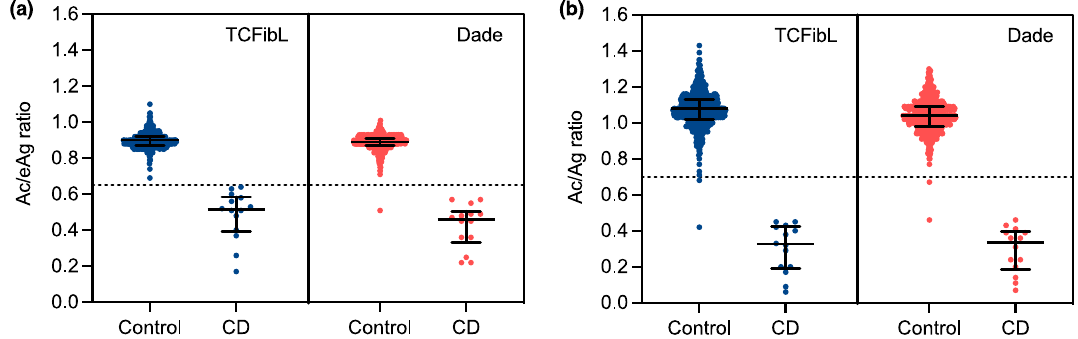
Figure 2. Comparison of Ac/eAg and Ac/Ag ratio in validation cohort. A scatter plot for Ac/eAg ratio ( a ) and Ac/Ag ratio ( b ) analyzed in the validation cohort. The left area shows results obtained with Thrombocheck FibL reagent (TCFibL, blue), and the right area shows results obtained with Dade Thrombin Reagent (Dade, rose). The dotted line shows the predicted cutoff of 0.65 ( a ) or the previously suggested cutoff of 0.70 ( b ). Bars show median with interquartile range. CD, congenital (hypo)dysfibrinogenemia.